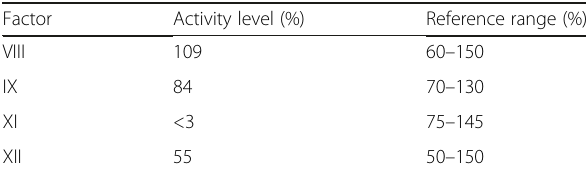
Table 1 Coagulation factor